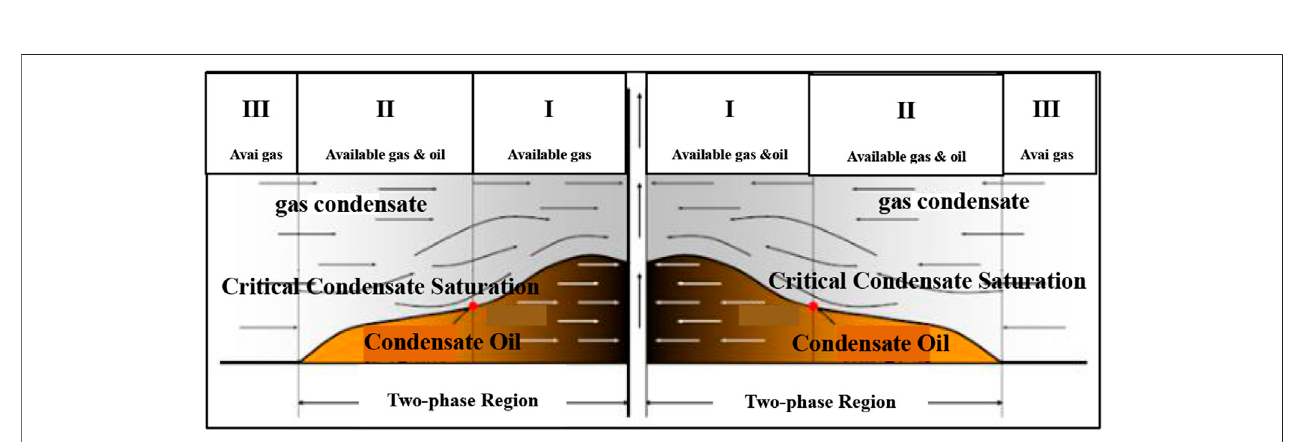
FIGURE 2 | Distribution of condensate near the wellbore zone.